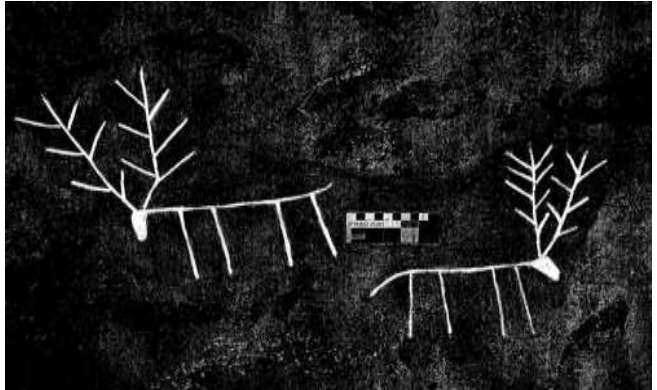
Figure 16. Karaftou Cave, drawing of two